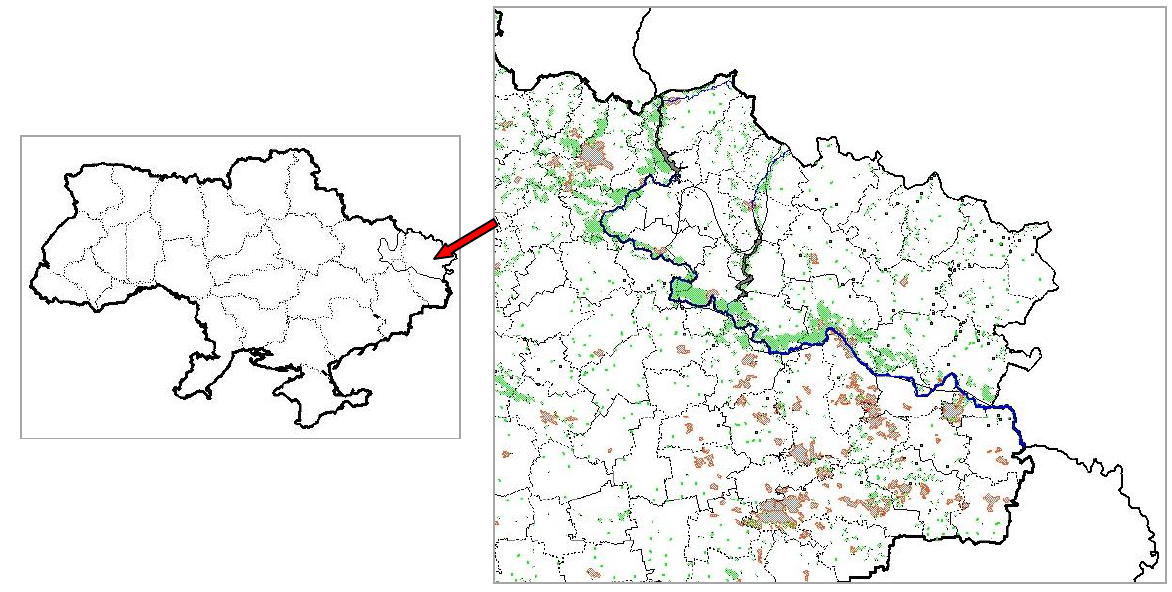
Fig. 1. Location of the Starobilsk grass-meadow